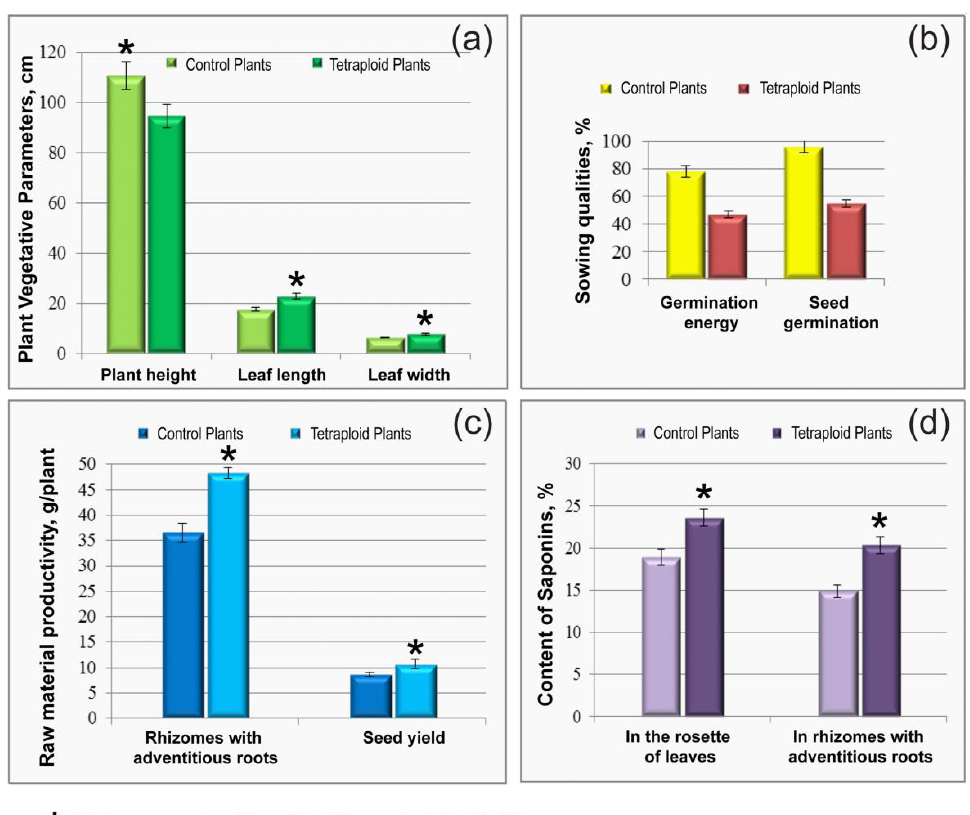
Figure 4. Vegetative parameters: Plant height, Leaf length, Leaf width ( a ); Sowing qualities ( b ); Raw material productivity ( c ) and also Content of saponins ( d ) in the control and colchicine-induced tetraploid plants of Polemonium caeruleum. * Values are significantly different at p ≤ 0.05. Table 1. Effects of colchicine treatment on morphometric parameters and productivity of plants in Polemonium caeruleum.